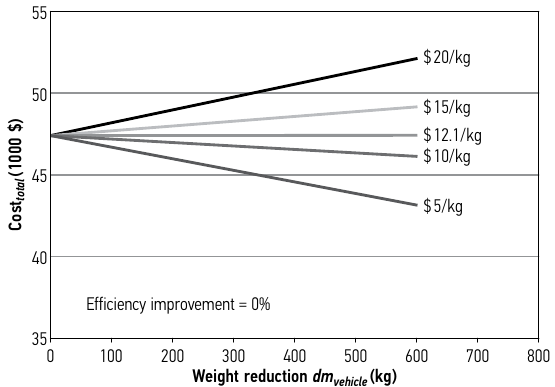
Fig. 3. Total lifetime cost variation for various lightweighting technology costs without efficiency improvement and a fuel price of